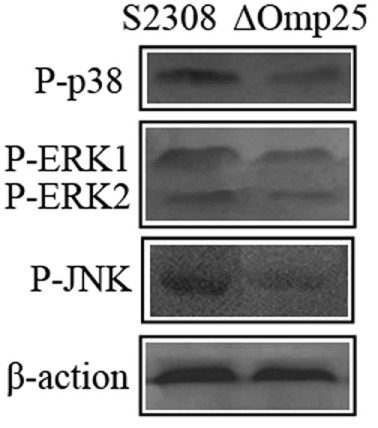
Activation of p38, ERK1/2, and JNK kinases in S2308 and 2308ΔOmp25-infected HPT-8 cells. HPT-8 cells were infected with S2308 or 2308ΔOmp25 at a 100:1 MOI. At 24 h post-infection, supernatant was discarded, and cells were lysed. Then, the activation of p38, ERK1/2, and JNK kinases was detected by Western blotting. Infections with 2308ΔOmp25 induced a markedly weaker stimulation of p38, ERK1/2, and JNK kinases, with S2308 demonstrating a slightly higher capacity of activation than 2308ΔOmp25. OMP25, outer membrane protein 25; JNK, Jun-N-terminal kinase; MOI, multiplicity of infection.